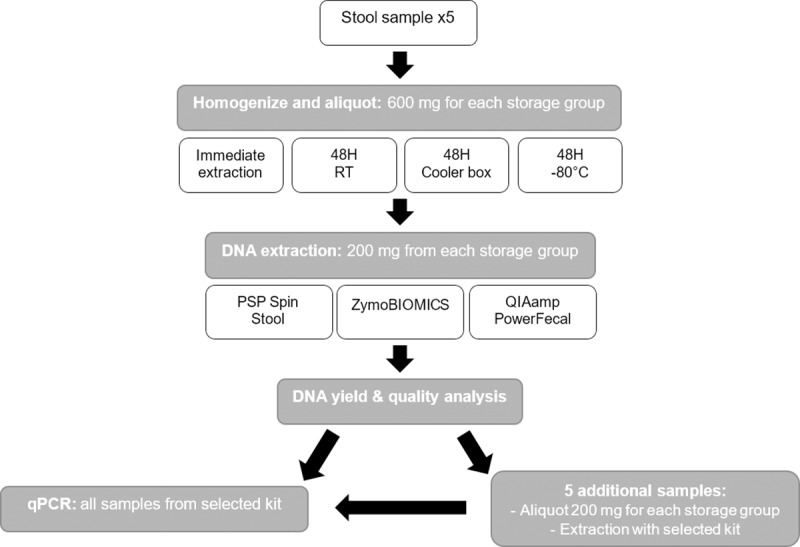
Workflow for aliquoting and extraction of stool samples.RT = Room temperature.